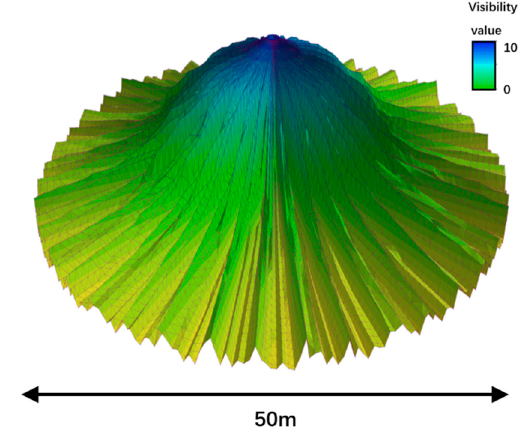
Figure 7. ‘Visibility fortress’ hint. Visibility data from sample 2021-05-17-11-08-33. The center of the ‘visibility fortress’ is the location of the boar’s nest. The original visibility ranges from 0 to 1. To clearly show the spatial distribution of the visibility on a 50-m scale, we scaled the visibility to 0–10. We used a triangular irregular network surface to display the visibility surface to completely preserve the distribution details of the visibility in the 3D space. We did not use the model to fit the visibility surface because we were not sure if those details were important in the 3D space.